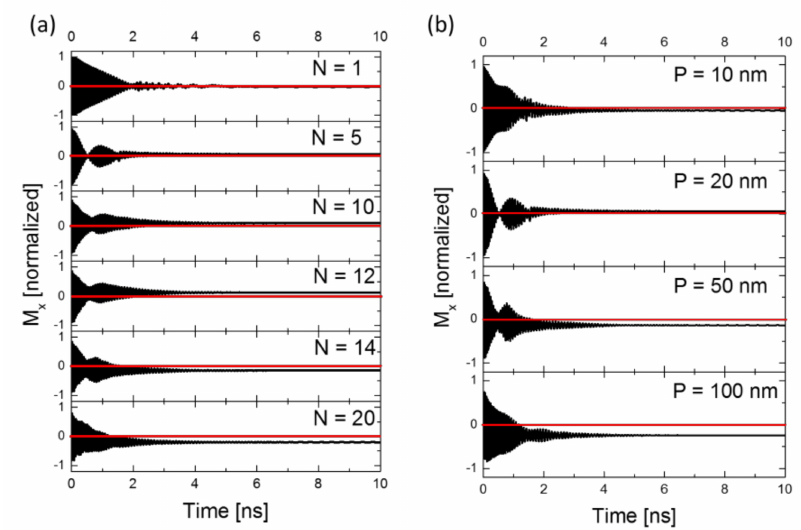
Figure 4. The effect of increasing the ( a ) periodicity N and ( b ) period P of the nanograting structure on M x temporal plots. Other geometry parameters are fixed. Material parameters; α = 0.013 and M s = 840 × 10 3 A m − 1 . Excitation frequency is 3 GHz with 500 mT RF and 1000 mT DC bias field.